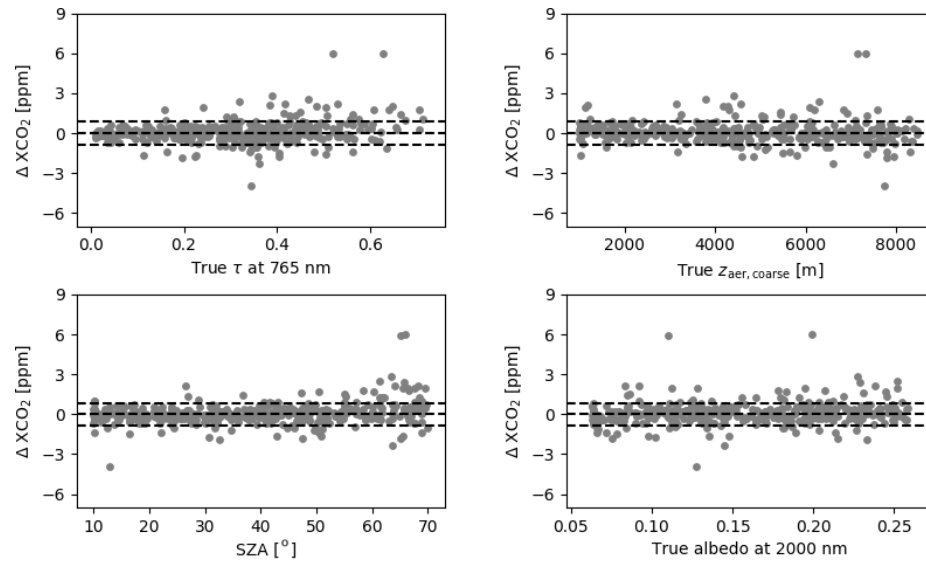
Figure 8. Same as Fig. 7 but for the converged joint retrievals using spectrometer and MAP-band measurements.